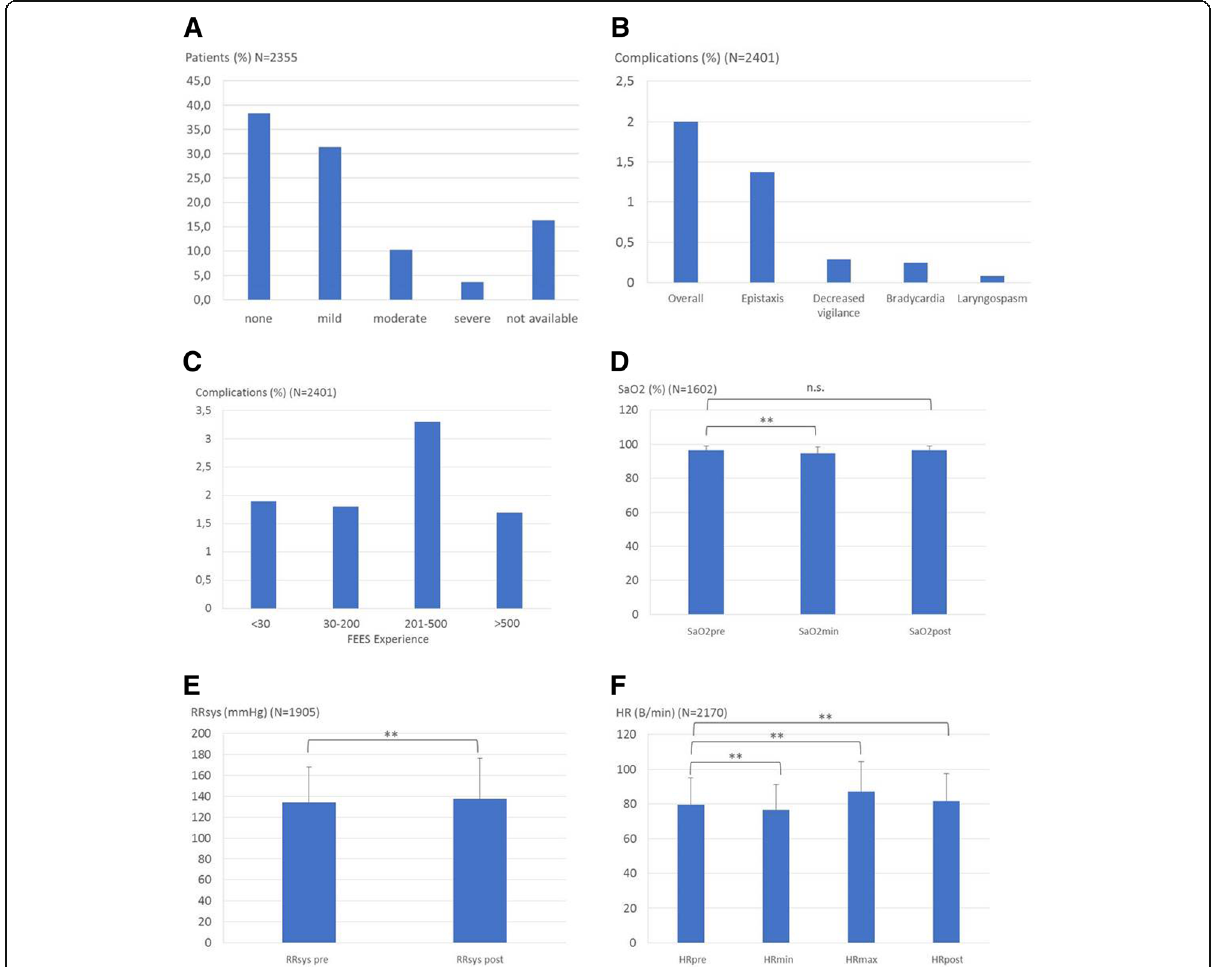
Fig. 1 Tolerance, complications and alterations of cardiorespiratory parameters during FEES. a : Patients ’ rating of FEES-associated discomfort ranging from none to severe; b : Incidence of complications; c : Incidence of complications in relation to the clinician ’ s FEES-experience. Numbers below columns give the number of FEES performed during prior training; d : Procedure-related changes of oxygen saturation (SaO2); E: Procedure-related changes of systolic blood pressure (RRsys); F: Procedure-related changes of heart rate